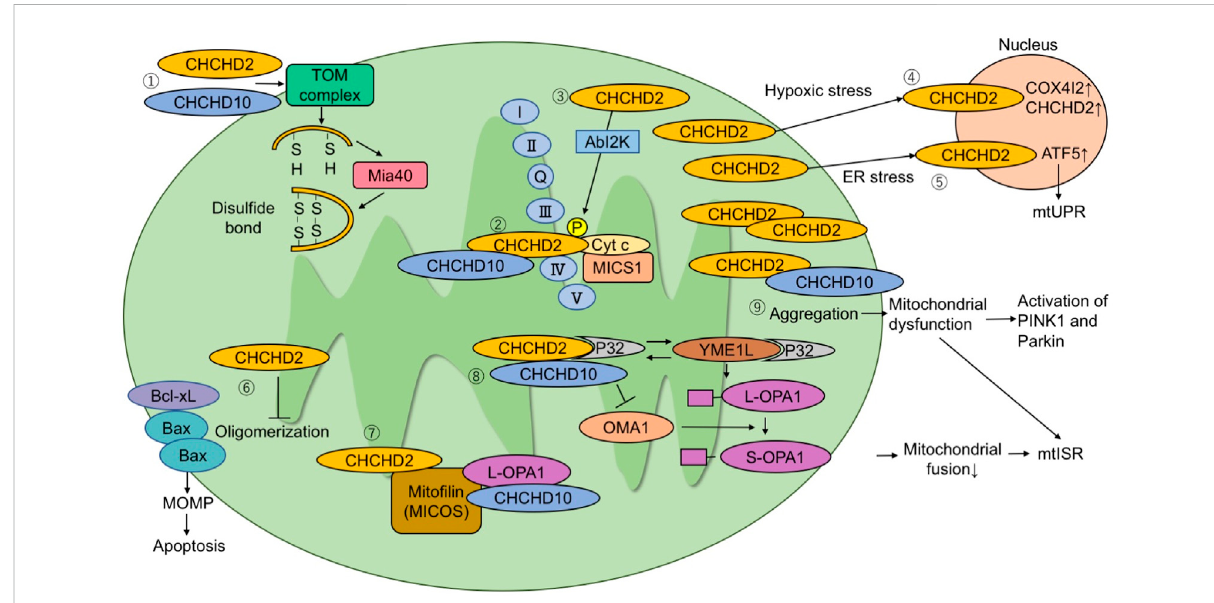
FIGURE 1 The molecular pathways proposed in literature. (1) CHCHD2 and CHCHD10 are imported to mitochondria via the TOM complex. They are folded after being imported and form a disul fi de bond via Mia40. (2) CHCHD2 regulates COX activity by binding to cytochrome c, MICS1, and COX. (3) Phosphorylation of CHCHD2 by Abl2 kinase enhances af fi nity for COX and respiratory activity. (4) Under hypoxic stress conditions, CHCHD2 accumulates in the nucleus and functions as a transcription factor for COX4I2 and CHCHD2. (5) Under endoplasmic reticulum stress conditions, CHCHD2 activates ATF5 and induces mitochondrial unfolded protein responses. (6) CHCHD2 inhibits Bax oligomerization and subsequent mitochondrial outer membrane permeability (MOMP), suppressing apoptosis. (7) CHCHD2 and CHCHD10 bind to mito fi lin to form a mitochondrial contact site and cristae organizing system (MICOS) complex. CHCHD10 binds to optic atrophy-1 (OPA1). MICOS complex is responsible for cristae morphology and maintenance in the mitochondria inner membrane. (8) P32 binds to CHCHD2 and YME1L. The interaction of P32 with YME1L accelerates the processing of L-OPA1 to S-OPA1. CHCHD2 competes with YME1L for P32 and suppresses OPA1 processing by YME1L.WhenL-OPA1decreases,mitochondrialfusionissuppressedandmtISRincreases.(9)WhenCHCHD10aggregatesinmitochondria,itcauses mitochondrial dysfunction and activation of the PINK1-Parkin